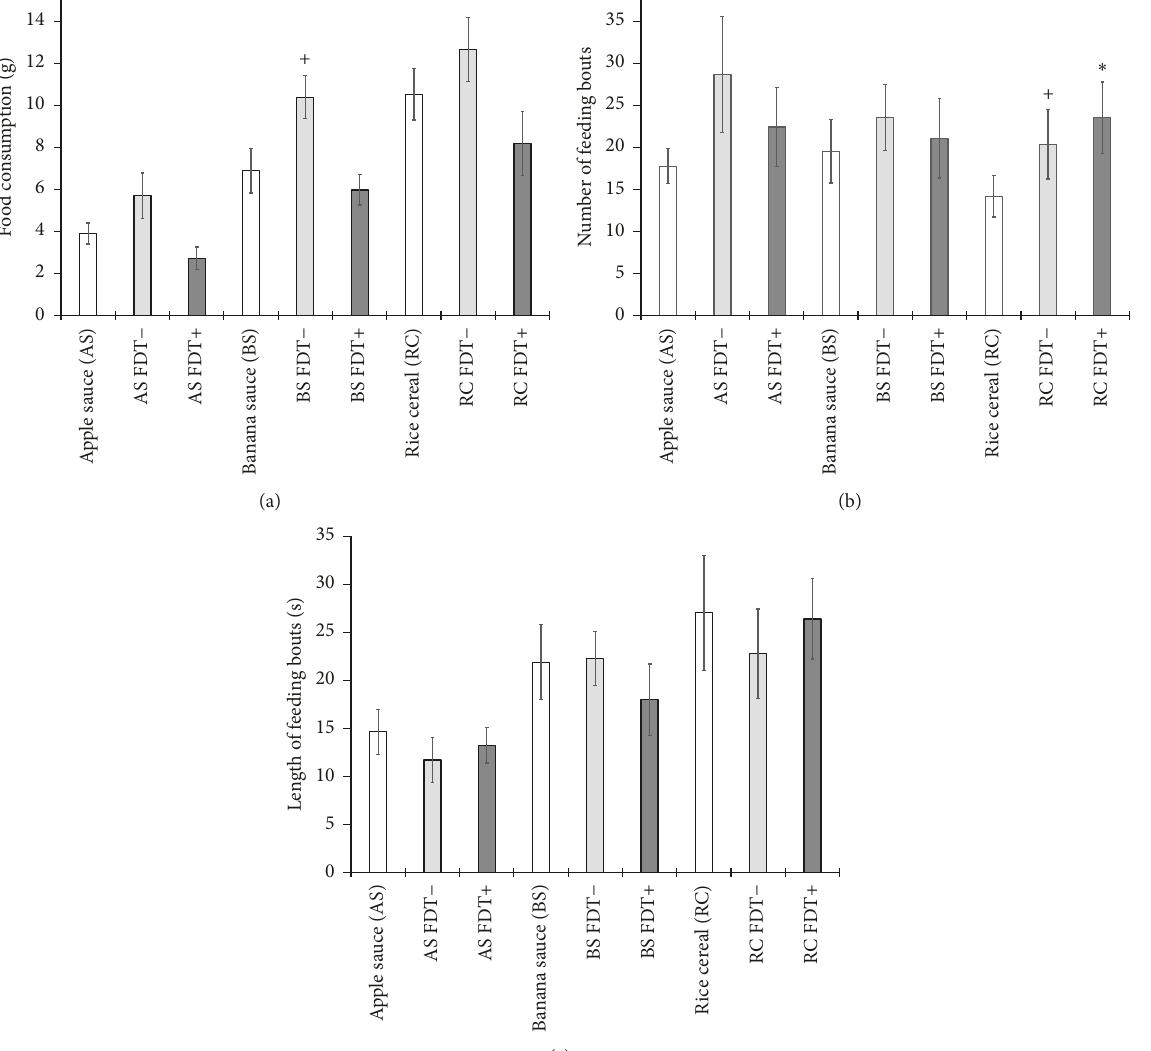
FDT+ ILIs suggests that the FDT containing the LPV/r elicits aversive orosensory signals not unlike strong bitter tastants, whereas the ILIs for the placebo FDT − (166.3 ± 8.4) and body- weight-adjusted FDT 1 : 30 (201.9 ± 21.4) did not differ from water (150.7 ± 2.3).